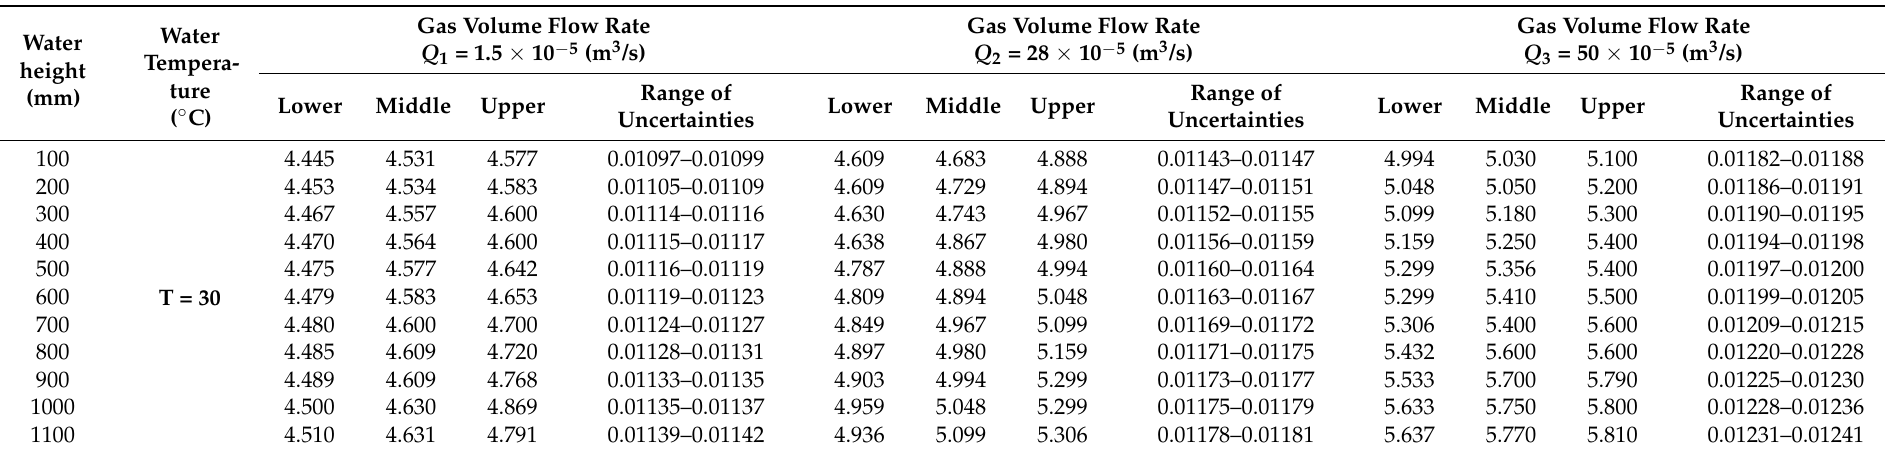
Table 3. Bubble diameter (mm) as a function of water height for T = 30 ◦ C and for gas volume flow rates Q 1 –Q 3